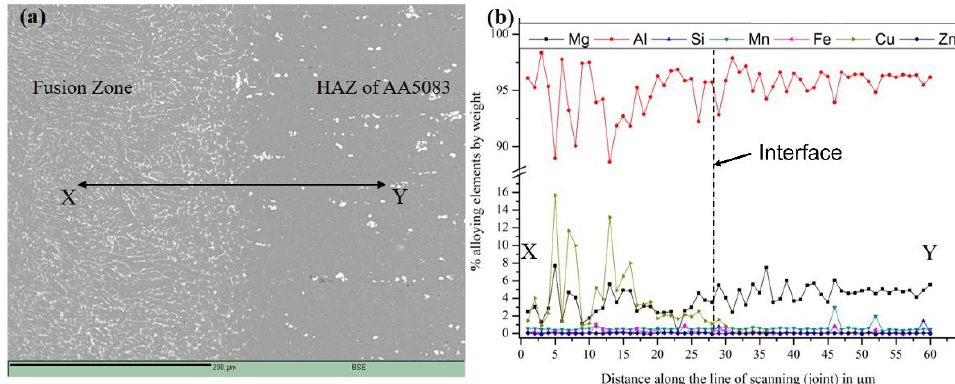
Figure 6. EPMA across fusion interface towards AA 5083 side. ( a ) Backscattered electron image; ( b ) elemental distribution along path XY.